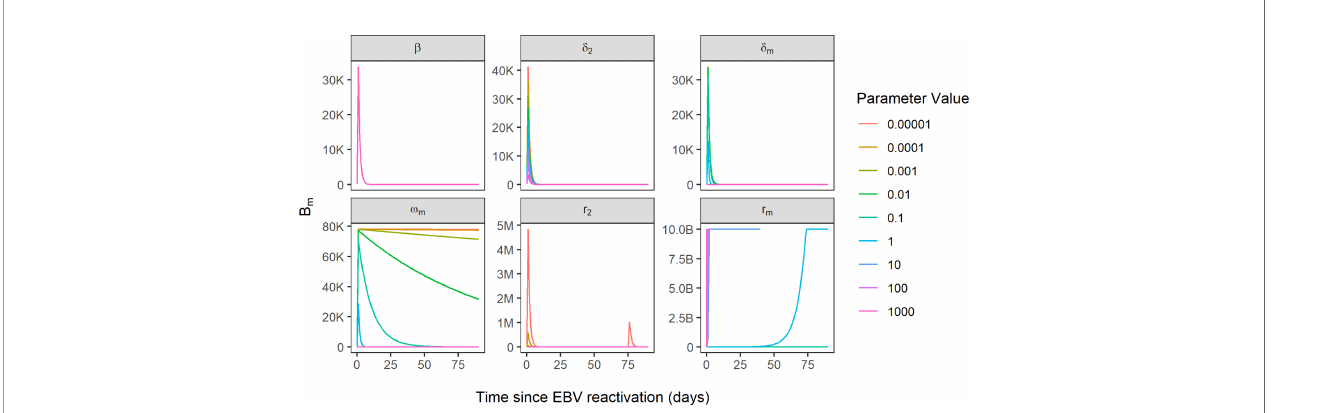
FIGURE 5 | Simulated EBV viral load trajectories, using B m compartment as a proxy for EBV VL. Sensitivity of EBV VL shown for the variation of six parameters over the range 0.00001-1000, where beta parameter represents reference model fi t and all other parameters are sensitive parameters. B, 1 billion; M, 1 million;